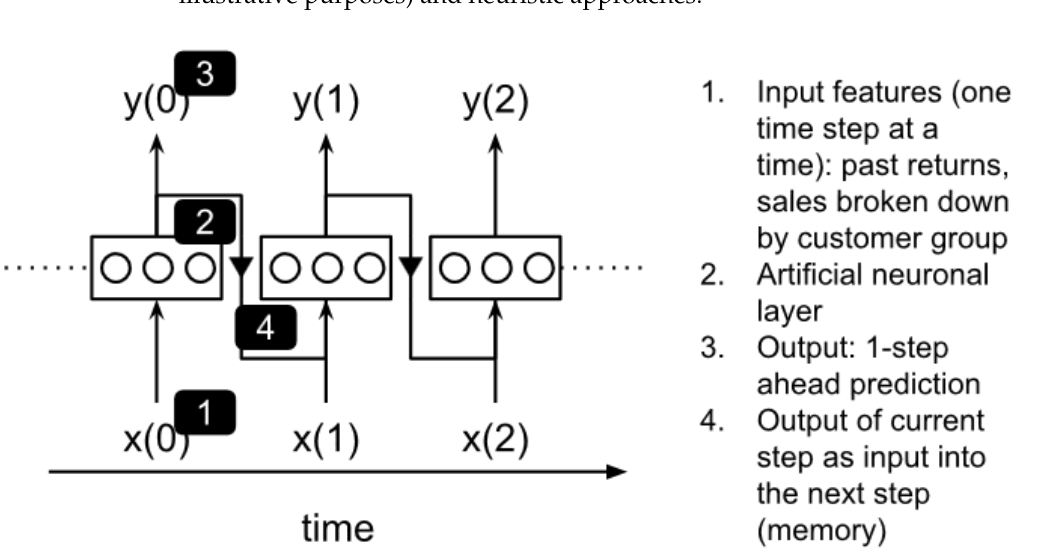
Figure 3. Schematic representation of the unrolling through time in the RNN architecture.